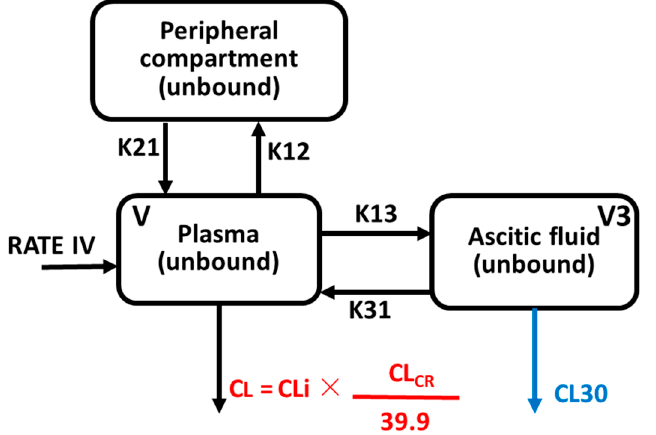
Figure 1. Graphical representation of PK final model: V (L), the volume of the central compartment; CLi (L/h), population parameter estimate of temocillin clearance from central compartment; CL (L/h), typical estimate of clearance from central compartment; K12 (h − 1 ), first-order rate constant for distribution from central to peripheral compartment 2; K21 (h − 1 ), first-order rate constant for distri- bution from peripheral compartment 2 to central compartment; K13 (h − 1 ), first-order rate constant for distribution from central to peripheral compartment 3 (ascitic fluid compartment); K31 (h − 1 ), first-order rate constant for distribution from peripheral compartment 3 to central compartment; V3 (L), volume of the compartment 3; CL30 (L/h), clearance from compartment 3 defined as the product between of first-order elimination rate constant from compartment 3 (K30 (h − 1 )) and volume of the compartment 3 (V3 (L)).